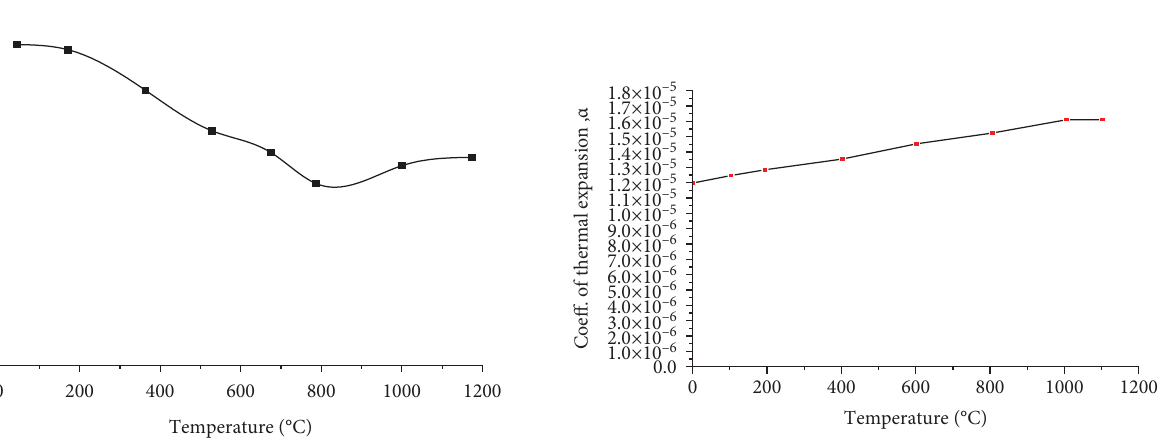
Figure 15: Termal conductivity of steel at elevated temperatures [24].